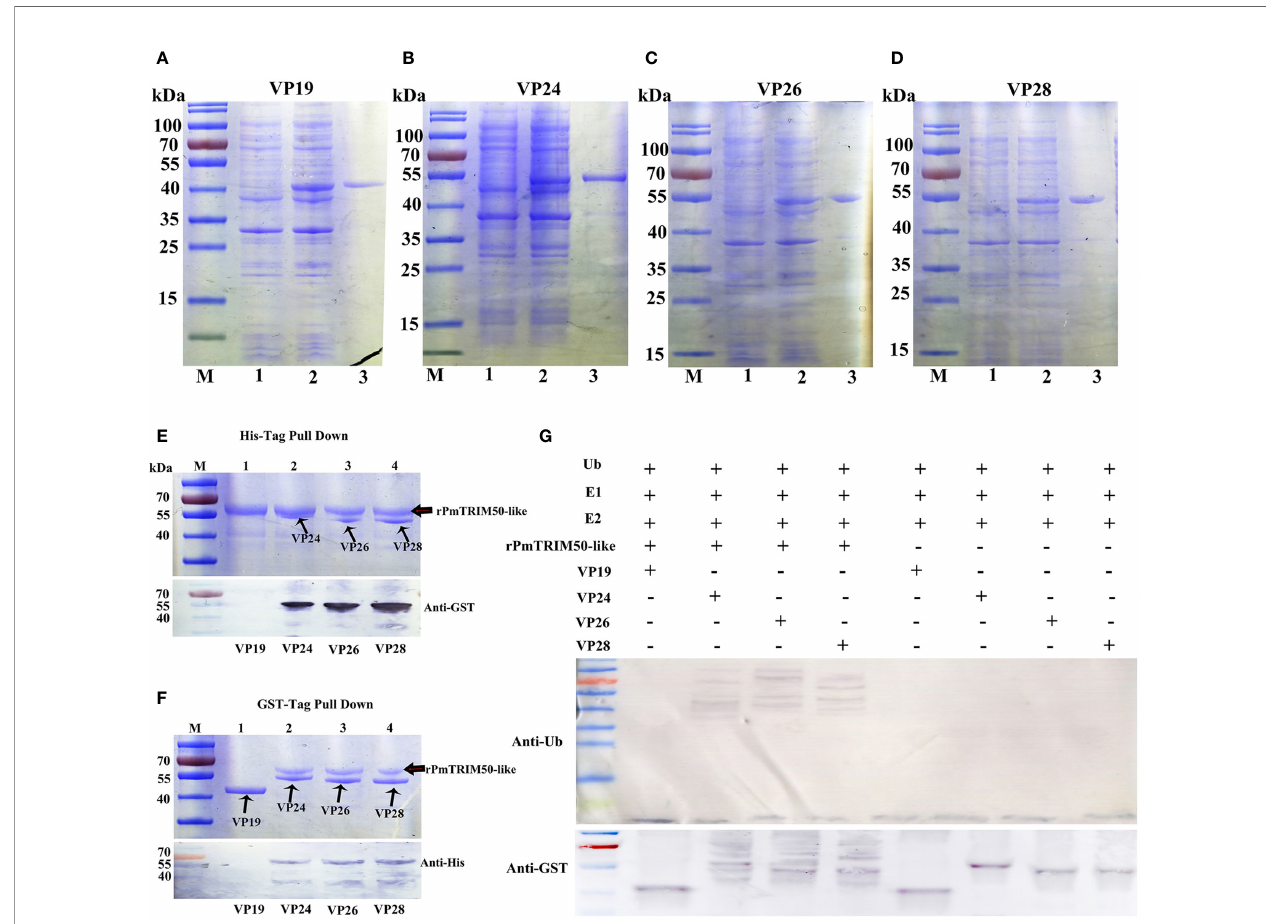
FIGURE 6 | PmTRIM50-like recognized components of WSSV and targeted them for ubiquitination in vitro . (A – D) Puri fi ed GST tagged WSSV structural proteins of VP19 (A) , VP24 (B) , VP26 (C) , and VP28 (D) . (E) His tagged PmTRIM50-like that interacted with GST-VP19, VP24, VP26, and VP28 was obtained in His pull-down assay and visualized by coomassie blue staining (upper panel) and con fi rmed by western blotting with anti-GST antibody (lower panel). (F) GST tagged VP19, VP24, VP26, and VP28 that interacted with His-PmTRIM50-like was obtained in GST pull-down assay and visualized by coomassie blue staining (upper panel) and con fi rmed by western blotting with anti-His antibody (lower panel). (G) In vitro ubiquitination of VP19, VP24, VP26, and VP28 by rPmTRIM50-like plus E1, E2, ATP and ubiquitin (Ub) as detected by anti-Ub antibody (upper panel) and anti-GST antibody (lower